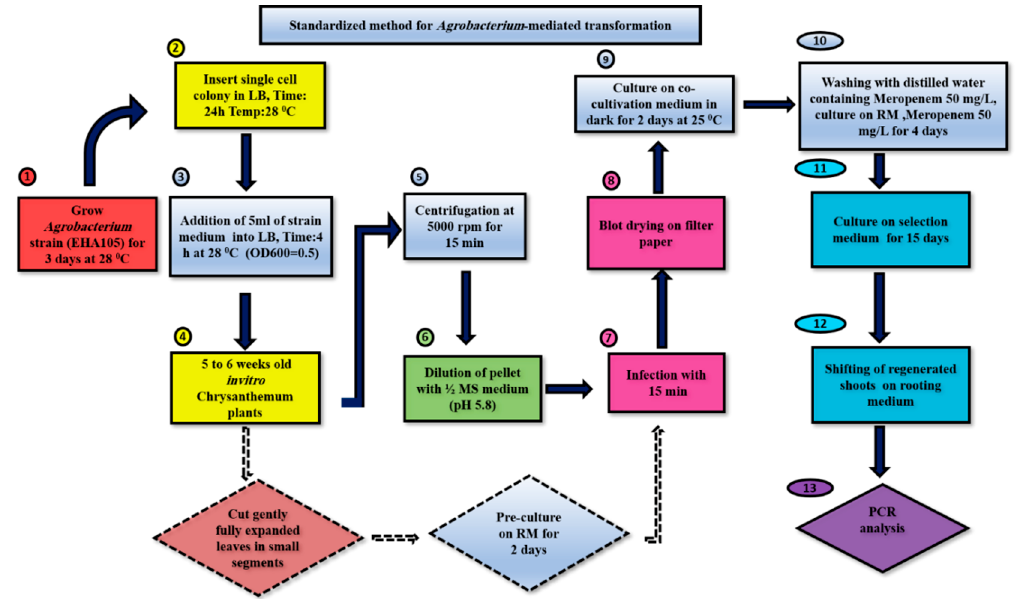
Scheme 1. Standardized protocol for transformation in chrysanthemum cv. Jinba. Regeneration